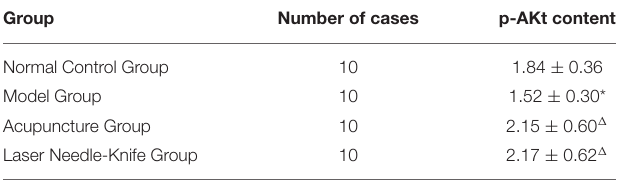
TABLE 5 | Comparison of mTOR content in CSA Rabbits ( ¯ x ± S) (ng/mg). Group